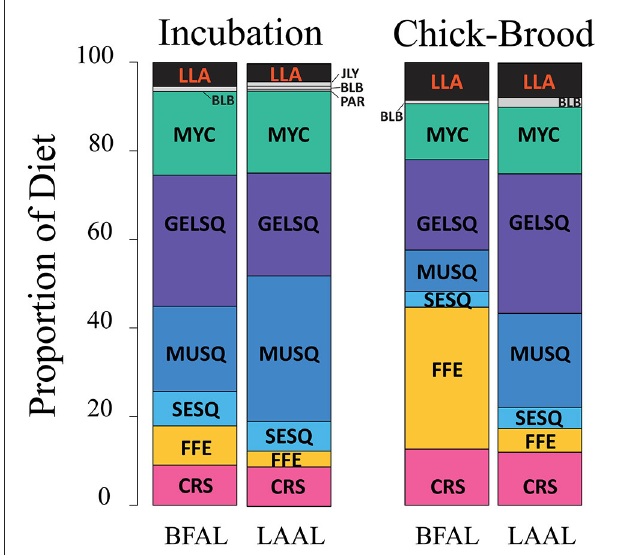
FIGURE 4 | Diet composition of black-footed (BFAL) and Laysan (LAAL) albatrosses across the incubation and chick-brood breeding phases. While the two species show high similarity in the functional groups exploited during incubation, the diet of black-footed albatrosses diverges during the chick-brood with a large increase in flying fish egg consumption. Outside of chick-brooding BFAL, squid (“SESQ,” “GELSQ,” “MUSQ”) composed, by far, the largest proportion of breeding Hawaiian albatross diet. Longline-associated prey (“LLA,” in red) is a marginal diet across both breeding phases and species, but increases slightly in proportional diet in the chick-brood breeding phase. Functional groups denoted by abbreviations: CRS, Crustacean; SESQ, Small Epipelagic Squid; MUSQ, Epi-Mesopelagic Muscular Squid; GELSQ, Bathy-Mesopelagic Squid; MYC, Mesopelagic Fish; LLA, Longline-Associated Prey; EPIFSH, Epipelagic Fish; FFE, Flying Fish Eggs; PAR, Ectoparasitic Copepod; BLB, Marine Mammal Blubber; JLY, Jellyfish.